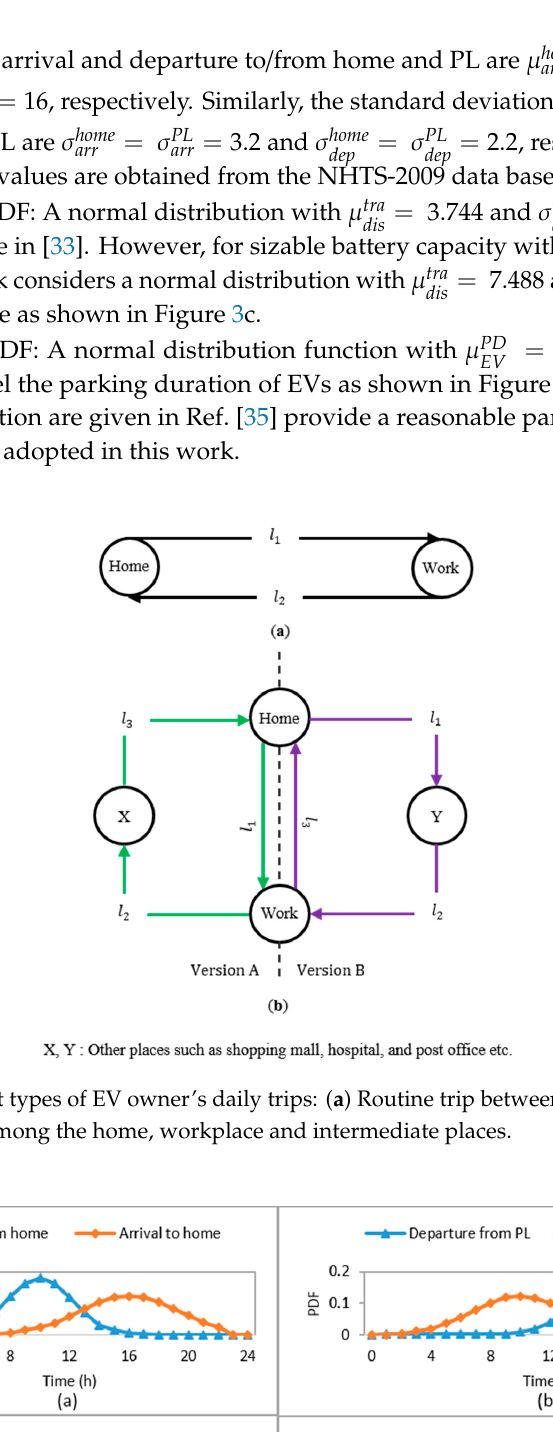
Figure 3. Probability distribution functions of arrival and departure time, distance and stay duration: